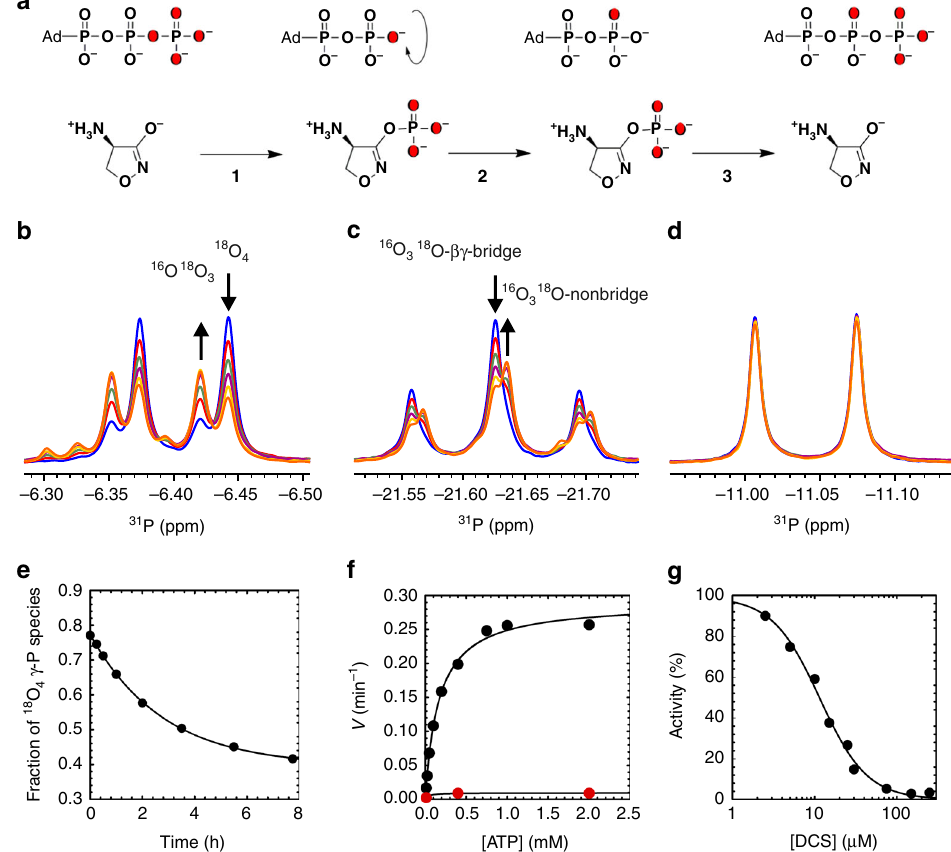
Fig. 2 Mechanism of DCS phosphorylation by EcDdlB as proved by positional isotope exchange (PIX) and steady-state kinetics of ATP hydrolysis and its inhibition by DCS. a Positional isotope exchange (PIX) mechanism for inhibition of EcDdlB by DCS. Position of 18 O label in the initial [ γ - 18 O 4 ]-ATP, intermediate and fi nal species is highlighted in red. b 31 P NMR spectra monitoring changes in the isotopic composition of γ -P (doublet), ( c ) β -P (triplet) and ( d) α -P (doublet) species of [ γ - 18 O 4 ]-ATP as a function of time: (blue) 15 s, (red) 0.5 h, (green) 3.5 h, (purple) 5.5 h, (yellow) 8 h, (orange) 18 h. In accordance with the reaction scheme reported in a , a PIX effect is observed both at γ -P and β -P position whereas, as expected, α -P remains unaffected. Based on the relative peak intensity the initial fraction of the [ γ - 18 O 4 ]-P species (blue, up fi eld doublet) and [ γ - 18 O 3 16 O]-P species (blue, down fi eld doublet) is 77% and 23%, respectively, consistent with a > 94% isotopic enrichment of each of the 4 oxygens. e Fractional occurrence of the [ γ - 18 O 4 ]-P species during the PIX reaction as a function of time. After 8 h upon addition of the enzyme at 25 °C, the fraction of the [ γ - 18 O 4 ]-P species decreased to 42%. The rate constant was obtained from fi tting of the data to Eq. (1). f Phosphatase activity of EcDdlB (black) as a function of ATP concentration and its inhibition by 1 mM DCS (red) were monitored by a coupled enzyme system assay (See Methods for details). Points are experimental data and lines best fi t to Eq. (2). g Inhibition of EcDdlB hydrolysis of ATP by DCS. Data were fi tted to Eq.